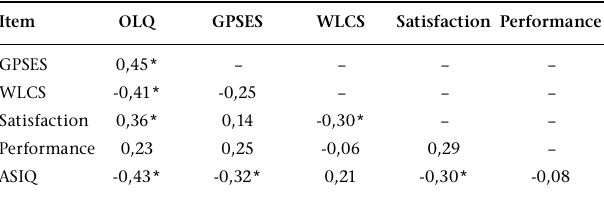
Table 2. In the case of the correlation between the ASIQ and the other constructs, Spearman correlation coefficients were computed because of the skewed distribution of suicide ideation scores. Table 2 also shows the Spearman correlation coefficients between the ASIQ and the other